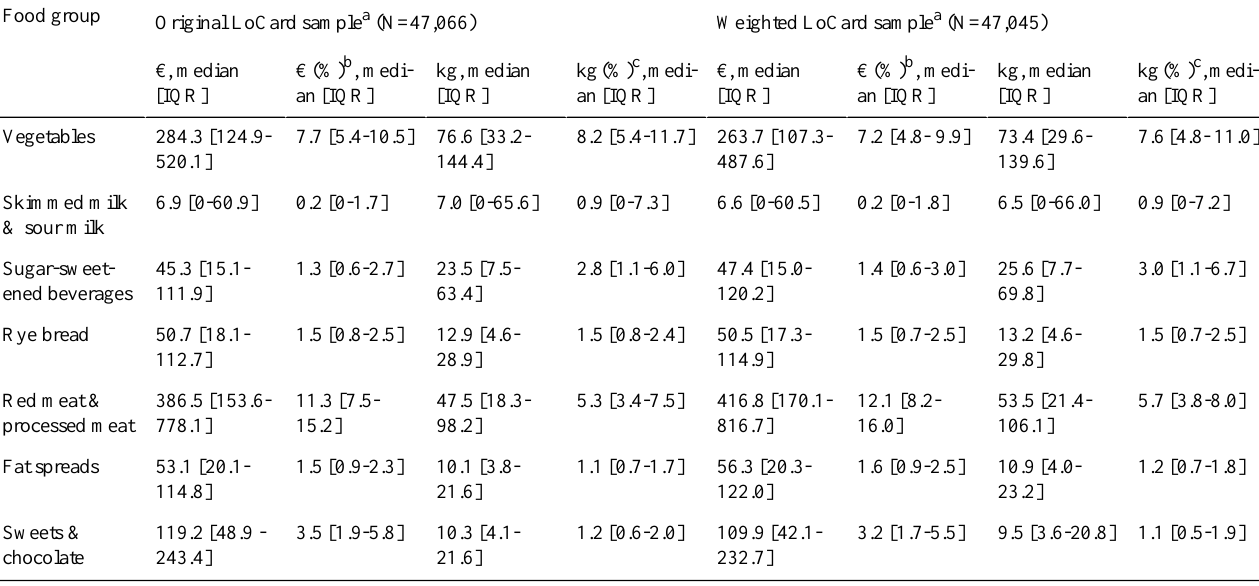
Table 2. Purchase of selected food groups (measured in € and kg) in the original LoCard sample and in the weighted LoCard